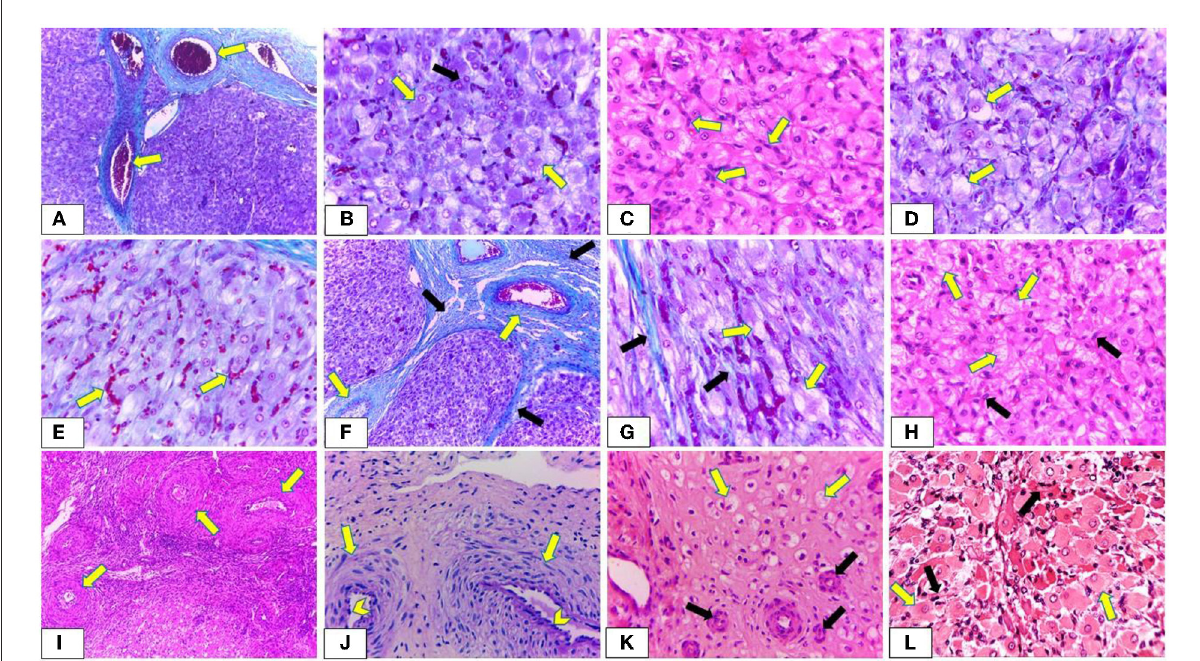
FIGURE11 Photomicrograph showing the histological structure of corpus luteum (CL) during oestrus cycle and pregnancy. (A,B) Demonstrating early luteal stage (Stage I). (A) The CL is covered by a highly vascularized connective tissue capsule and septa. The blood vessels are dilated and engorged with blood (arrow) (Crossman’s trichrome stain, x100). (B) Large lutein cells (LLCs) are ovoid, or polyhedral in shape with large spherical vesicular eccentrically situated nuclei and prominent nucleoli (yellow arrow) while small lutein cells are irregular in shape with eccentrical spherical lightly stained nuclei (SLCs) (black arrow). Furthermore, LLCs possessed more cytoplasmic: nuclear ratio and lipid droplets than that of SLCs (Crossman’s trichrome stain, x400). (C,E) Showing mid luteal stage (stage II). (C) Presence of numerous fibroblast cells (arrow) with increasing the size of LLCs (H & E, x400). (D) Revealing a high number of vacuolated lutein cells with large vacuoles (arrow) (Crossman’s trichrome stain, x400). (E) Most lutein cells appear in a close association with engorged blood capillaries (arrow) (Crossman’s trichrome stain, x400). (F,H) Revealing mid luteal stage (stage III). (F) Presence of a high amount of collagen fibers in the capsule surrounding CL and C.T. septae (black arrow) in addition to increasing the thickness of the blood vessels enclosed in both capsule and septae (yellow arrow) (Crossman’s trichrome stain, x100). (G) Presence of a high amount of collagen fibers in the interstitial tissue (black arrow). Furthermore, LLCs appear with abundant large vacuoles which are represented by narrow strands in some cells (yellow arrow) (Crossman’s trichrome stain, x400). (H) LLCs (yellow arrow) appear with abundant large vacuoles distributed among numerous fibroblast cells (black arrow) (H & E, x400). (I,K) Exhibiting late luteal stage (stage IV). (I) A substantial increase in the thickening of blood vessels enclosed within the C.T. capsule (arrow) (H & E, x400). (J)